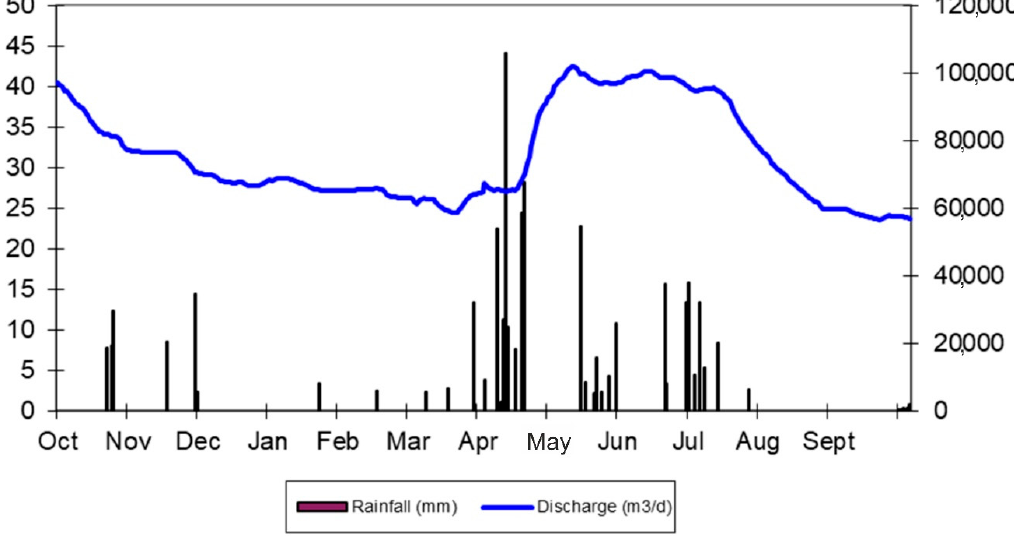
Figure 4. Monthly discharge of Deskatis River as measured at (1) before the karst aquifer (Deskatis bridge sampling point—in orange), (2) 1.5 km from Deskatis bridge and within the karst aquifer (Loutro sampling point—in yellow), and (3) 12 km from Deskatis bridge and within the karst aquifer (Valanidas sampling point–in green).